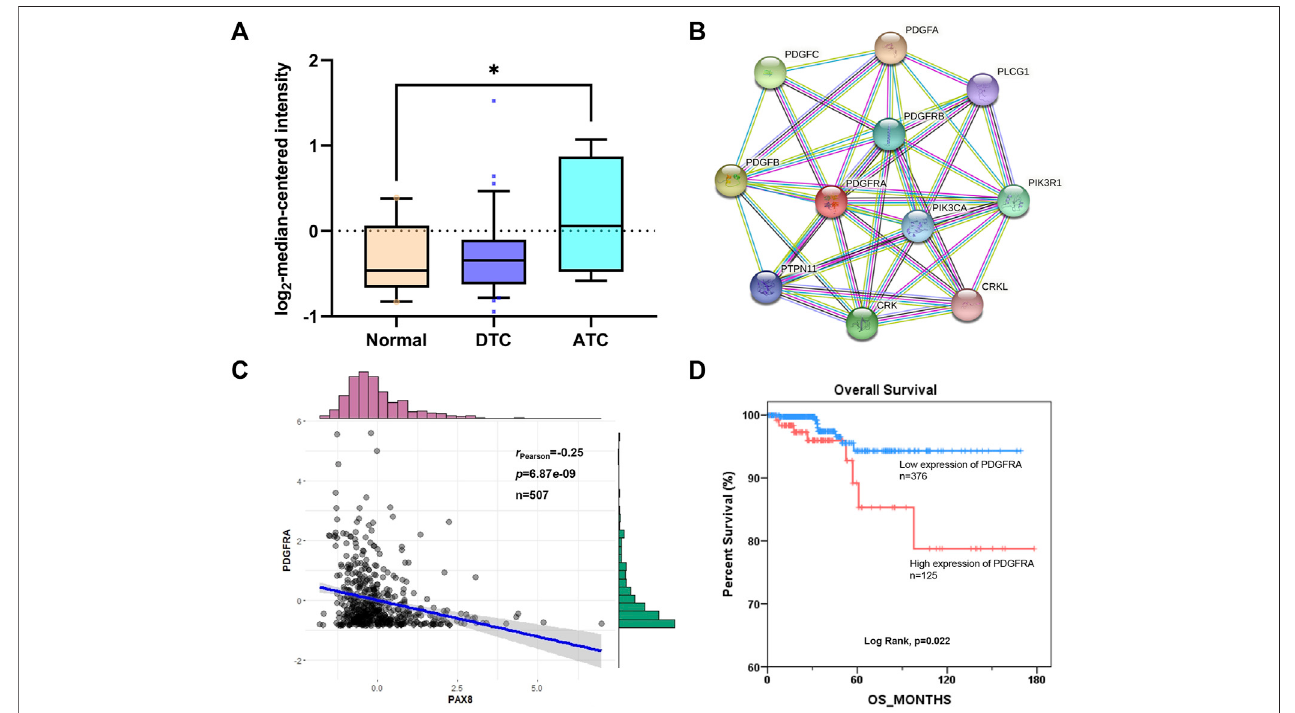
FIGURE 2 | The correlation between RDGFRA and radioiodine uptake of thyroid cancer. (A) The expression of PDGFRA in different types of thyroid cancer from Oncomine database. *, p < 0.05, compared with normal group. (B) The biological correlation between PDGFRA and related regulatory genes was analyzed based on STRING database. (C) Correlation between PDGFRA and PAX8 based on cBioPortal database. (D) Kaplan-Meier plot of overall survival-time of PDGFRA mRNA expression based on cBioPortal database. DTC: Differentiated Thyroid Cancer; ATC: Anaplastic Thyroid Cancer.